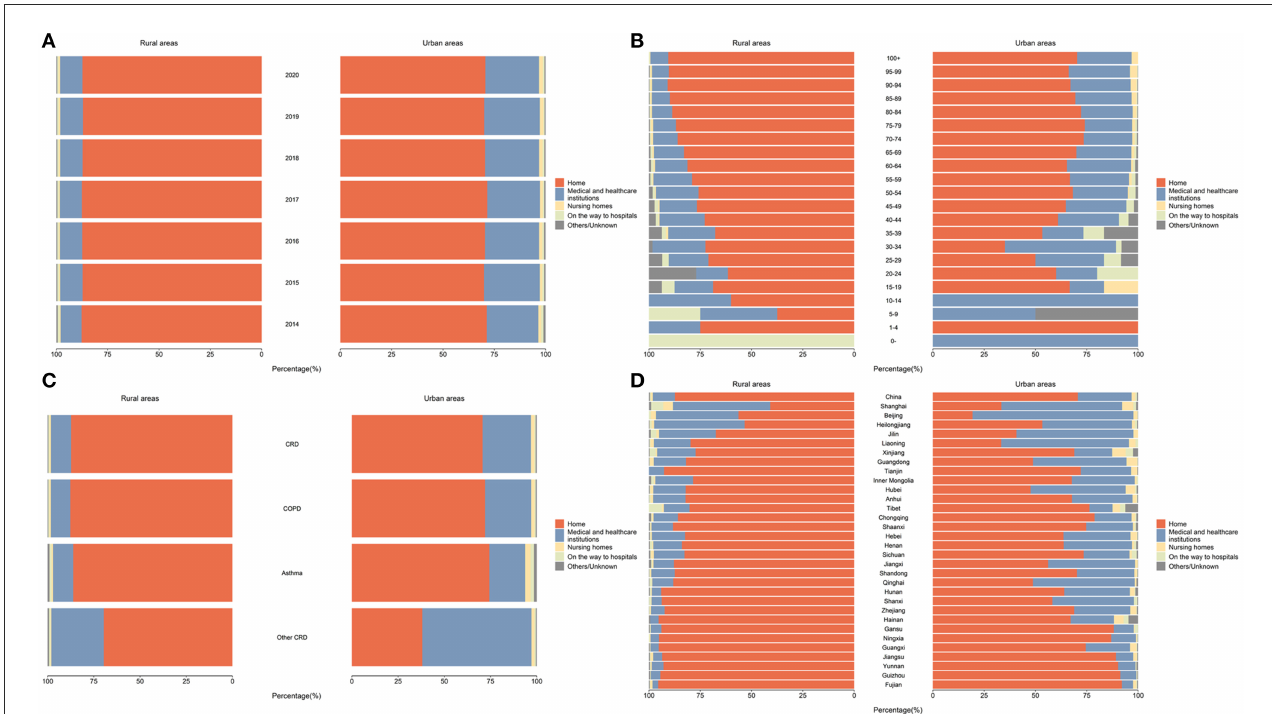
FIGURE3 The distribution of POD among CRD deaths in China, by rurality status (%). (A) Distribution of POD among CRD deaths in China, 2014–2020; (B) Distribution of POD among CRD deaths in China, by age, 2020; (C) Distribution of POD among CRD deaths in China, by CRD subcategories, 2020; (D) Distribution of POD among CRD deaths in China, by province,